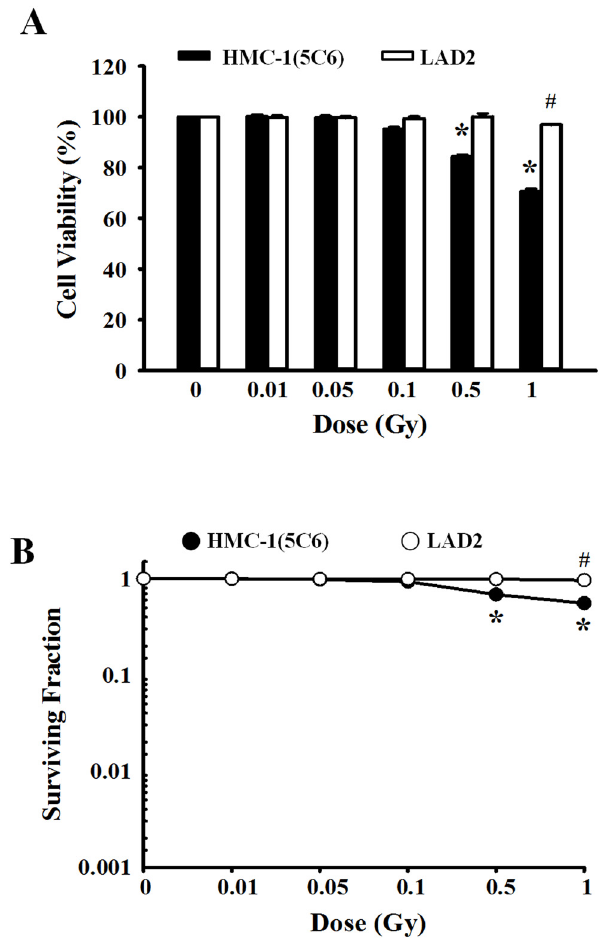
Fig 1. The effects of ionizing radiation on cell viability in human mast cells. HMC-1(5C6) and LAD2 cells were exposed to various doses (0 – 1 Gy) of ionizing radiation and incubated for 72 h (A) or 14 days (B). Cell survival was evaluated using MTT assays (A) and colony formation assays (B). Data represent the mean ± SEM from five independent experiments performed in duplicate. * p < 0.05, # p < 0.05 versus the corresponding control group of HMC-1(5C6) and LAD2 cells,